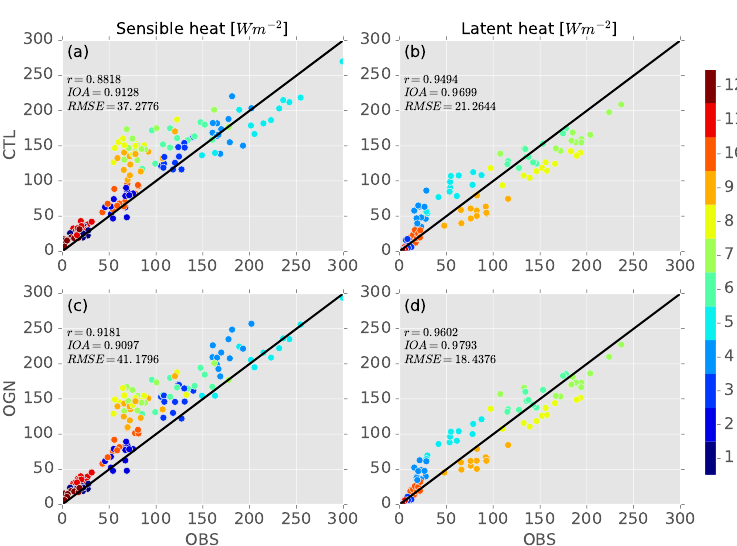
Figure 7. Scatter plots of the daytime monthly averaged (a) sensible heat fluxes and (b) latent heat fluxes (Wm − 2 ) for CTL vs. the observation above the canopy; the monthly averaged (c) sensible heat fluxes and (d) latent heat fluxes (Wm − 2 ) for OGN vs. the observation above the canopy. The color represents each month from January (1) to December